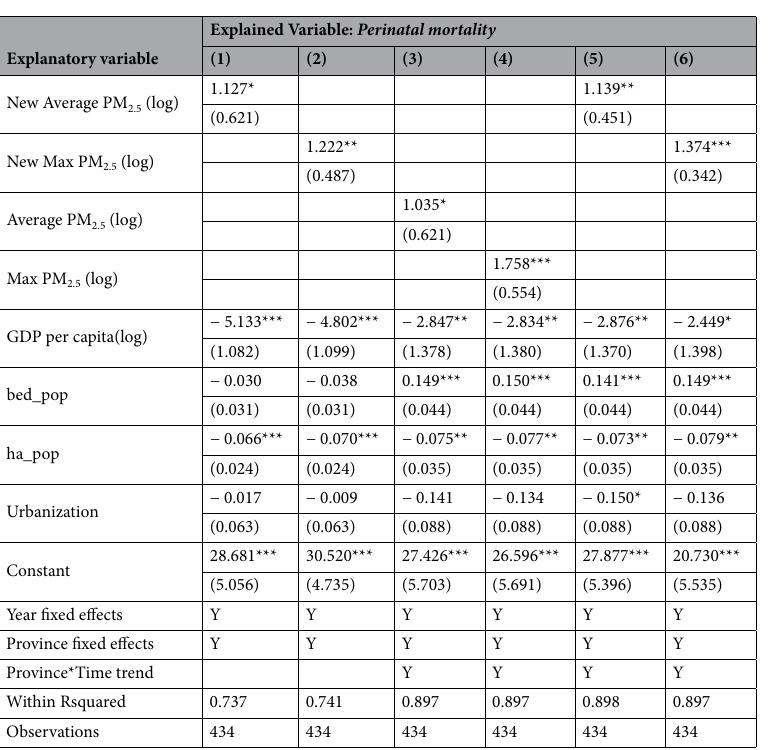
Table 3. Robustness check. Standard in parentheses, * p < 0.1, ** p < 0.05, *** p <